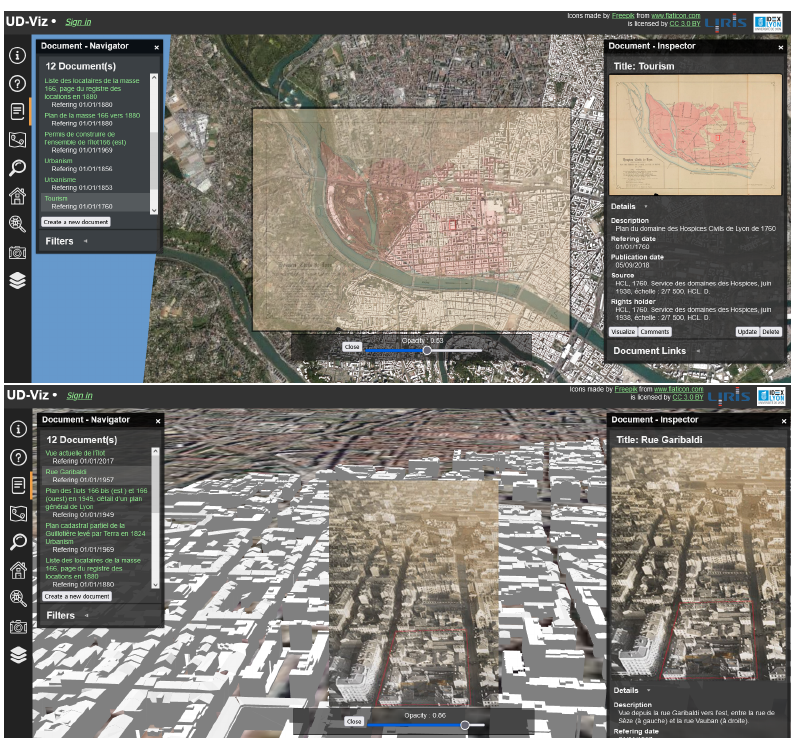
Figure 3. Three-dimensional visualization of buildings and associated documents (See more examples in